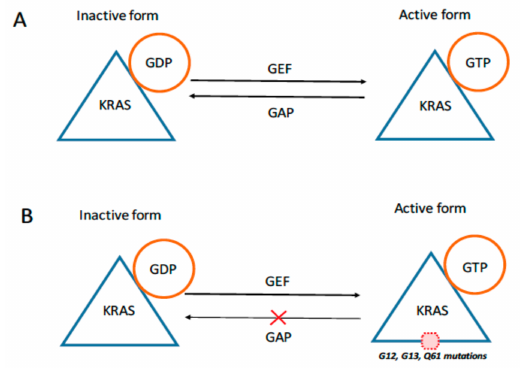
Figure 1. A schematic of KRAS signaling in normal ( A ) and tumoral ( B ) cells is shown. Mutant KRAS is permanently in a GTP-bound active